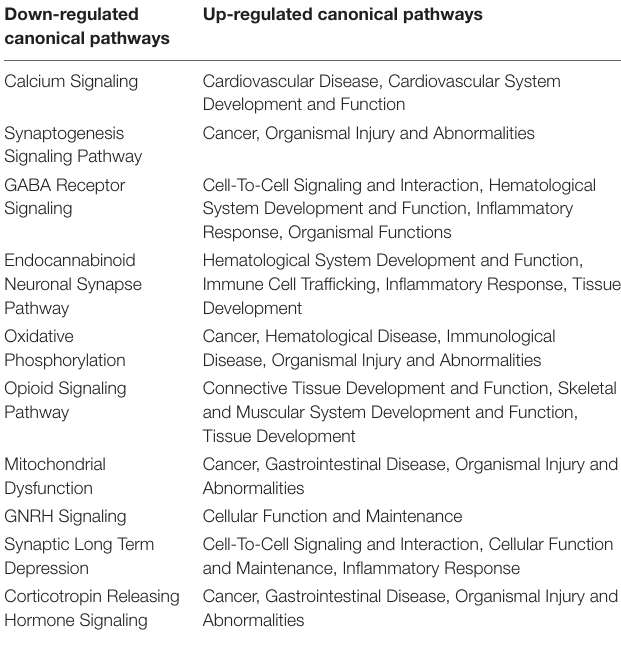
TABLE 1 | Down- and up-regulated canonical